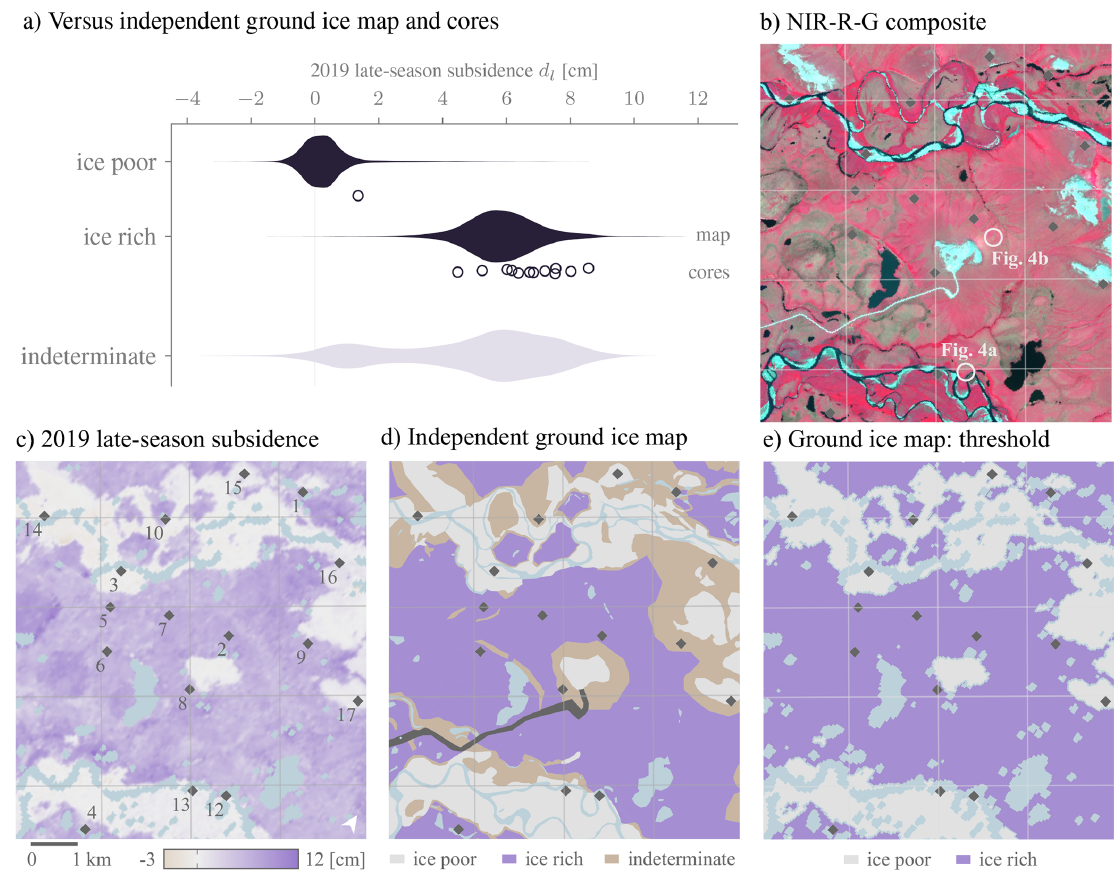
Figure 7. Assessment of late-season subsidence with respect to an independent ground ice map of the focus area defined in Fig. 5. (a) Kernel density distribution of d l in 2019 over areas independently determined to be ice rich and ice poor. The markers just below the kernel density estimates show the observations at the boring locations (triangles in Fig. 5). (b) Sentinel-2 false-colour composite (Copernicus Sentinel, 2020) for the focus area defined in Fig. 2. (c) The estimated d l , (d) the independently determined ground ice map, and (e) the ground ice classification obtained by thresholding d l . The diamonds indicate points mentioned in Figs. 6 and